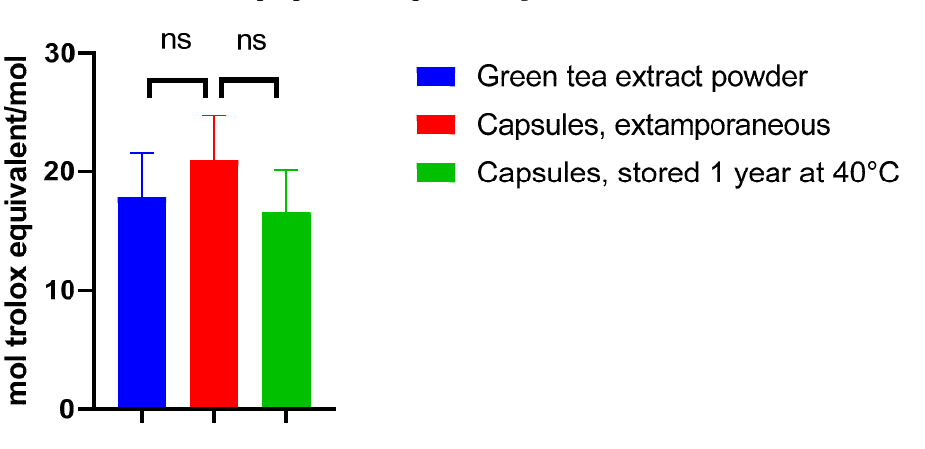
Figure 5. Evolution of EGCG (assay, % with respect to time 0) as a function of time and storage conditions.